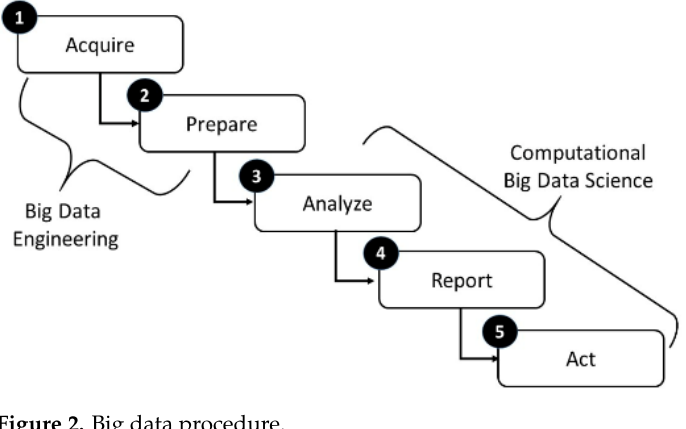
Figure 2. Big data procedure.